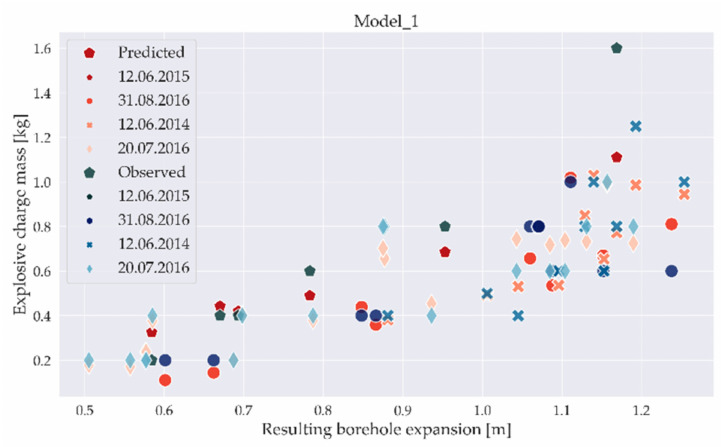
Figure 6. Model_1—Explosive charge mass vs. resulting borehole